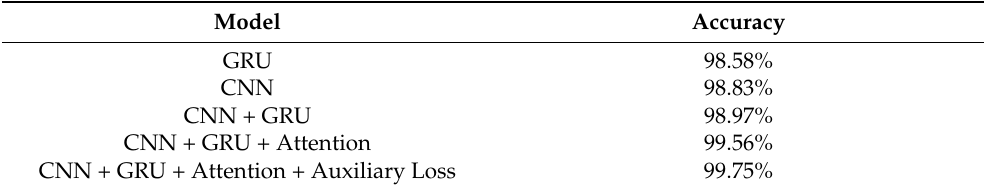
Table 4. Ablation